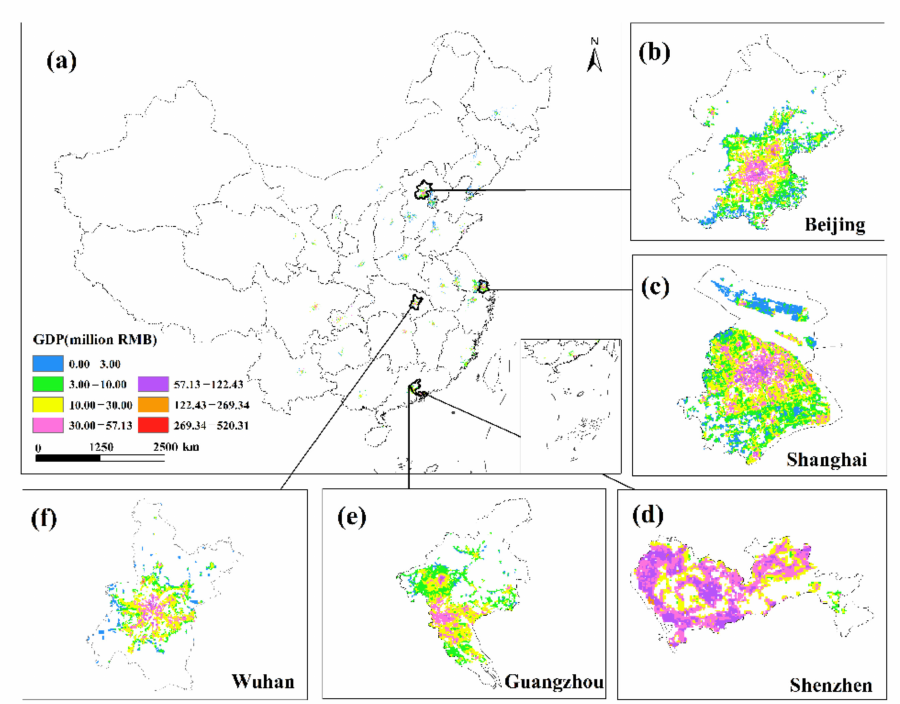
Figure 12. The spatial distribution of the total GDP of the secondary and tertiary industries in May 2020. ( a ) The spatial distribution of the total GDP in 34 Chinese cities; ( b ) Beijing; ( c ) Shanghai; ( d ) Shenzhen; ( e ) Guangzhou; ( f ) Wuhan.